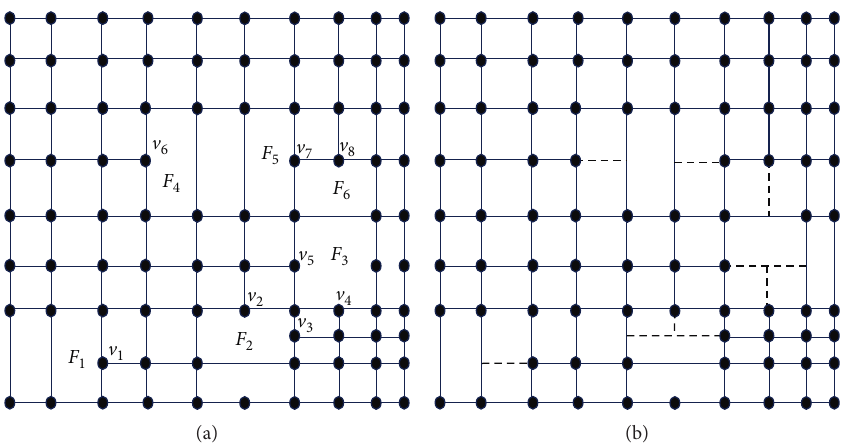
Figure 3: The proposed algorithm for extending T-vertices. (a) Design-suitable T-mesh; (b) extended T-mesh T